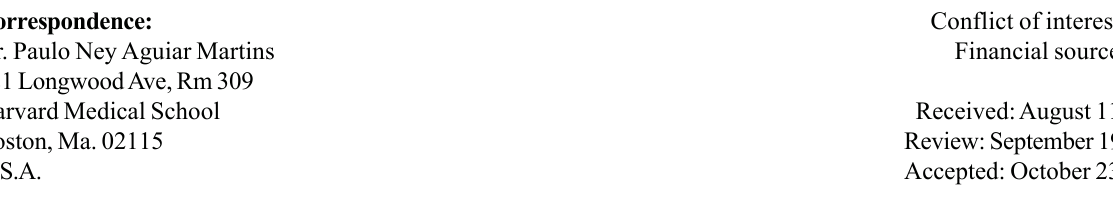
*Color figure available from